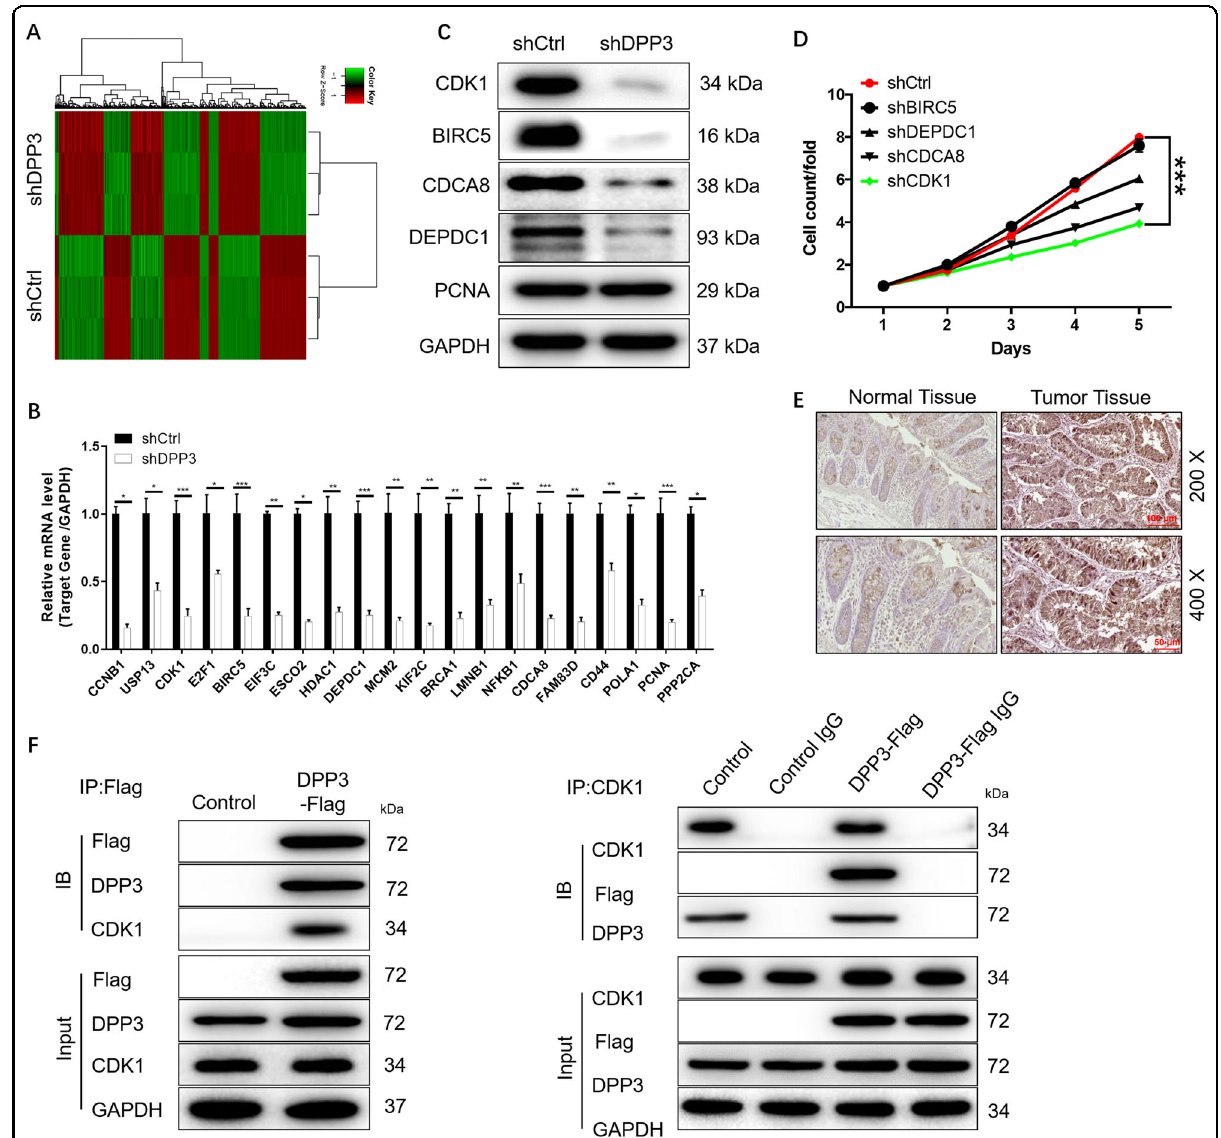
Fig. 4 The exploration and veri fi cation of downstream underlying DPP3 induced regulation of CRC. A A Prime View Human Gene Expression Array was performed to identify the differentially expressed genes (DEGs) between shDPP3 and shCtrl groups of HCT 116 cells. B , C The mRNA expression of several selected DEGs in HCT 116 cells with or without DPP3 knockdown was detected by qPCR and WB ( C ). D Celigo cell counting assay was used to compare the effects of different targets on cell proliferation. E The expression of CDK1 in CRC tissues and normal tissues was evaluated by IHC analysis. F The potential mechanism between DDP3 and CDK1 was demonstrated through Co-IP assay. Data were shown as mean ± SD. * P < 0.05, ** P < 0.01, *** P <